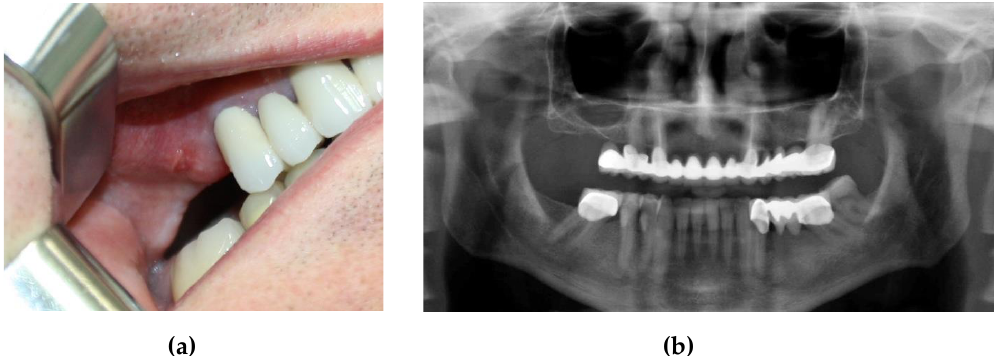
Figure 1. ( a ) Initial clinical assessment; ( b ) preoperative orthopantomogram (OPG) showing an insufficient height for Figure 1. (a) Initial clinical assessment; (b) preoperative orthopantomogram (OPG) showing an insufficient height for an implant insertion in the maxillary right first molar edentulous site. implant insertion in the maxillary right first molar edentulous